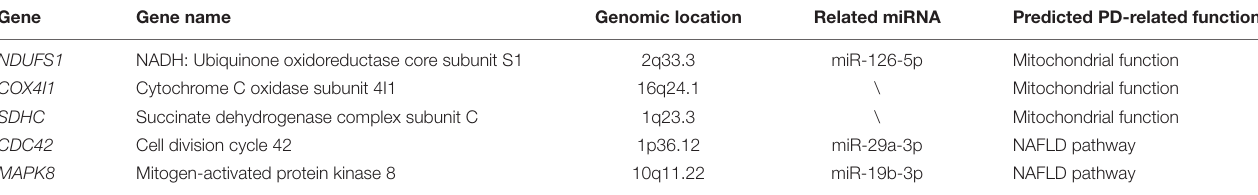
TABLE 4 | Priority genes, related miRNAs, and